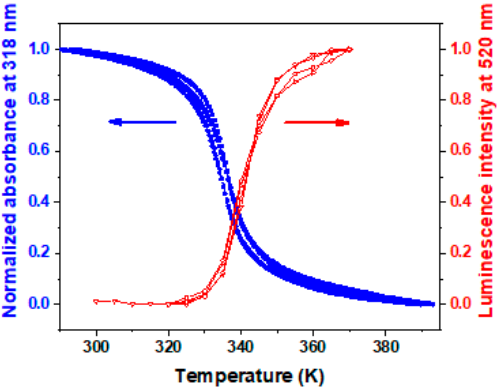
Figure 3. Luminescence modulation: Normalized temperature dependence (over two heating-cooling cycles) of the UV absorbance (318 nm) and of the luminescence intensity (excitation: 300 nm, emission 520 nm) for a bilayer film of 30 + 107 nm thickness.